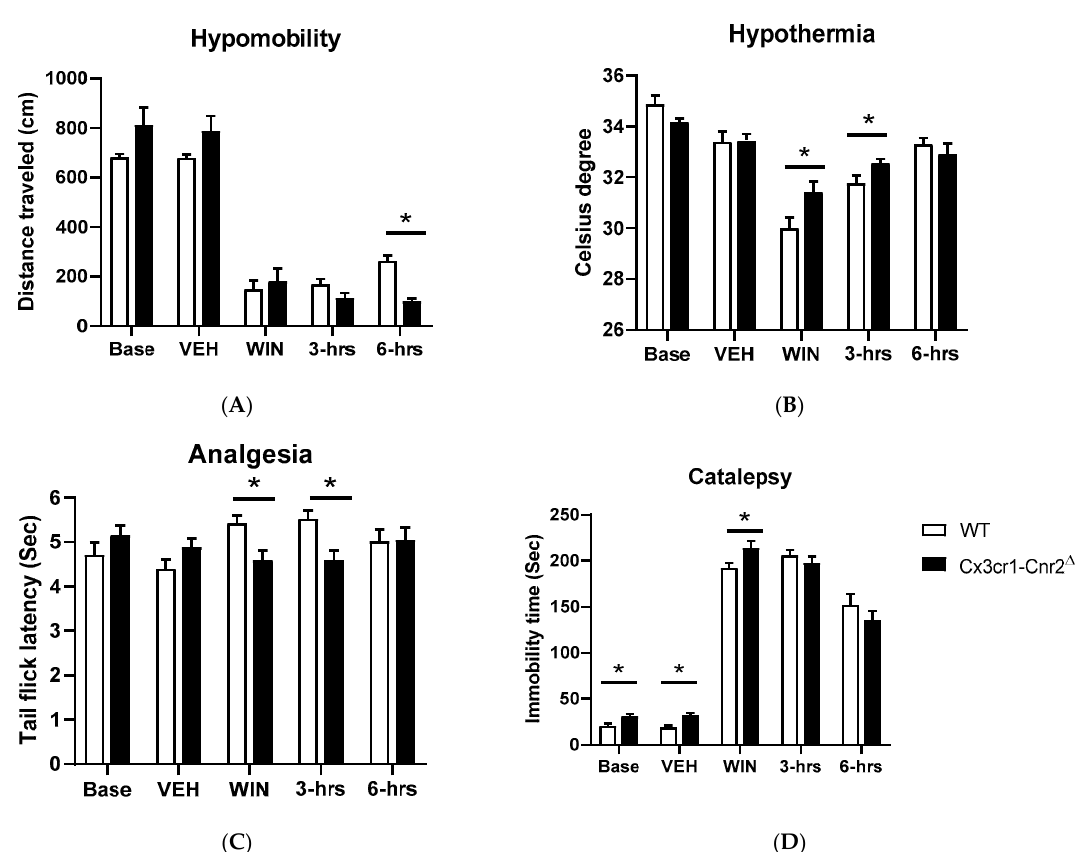
Figure 6. CB2R-mediated behaviors in the tetrad effects in WT, Cx3cr1-Cnr2 mice. The effects of the selected dose of the mixed CB1R and CB2R ligand WIN 55212-2 (3.0 mg/kg) in the tetrad effects. ( A ) Hypomobility; ( B ) hypothermia; ( C ) analgesia (tail-flick nociception test and a similar result in the hot plate test); ( D ) catalepsy. Asterisks represent p < 0.05.